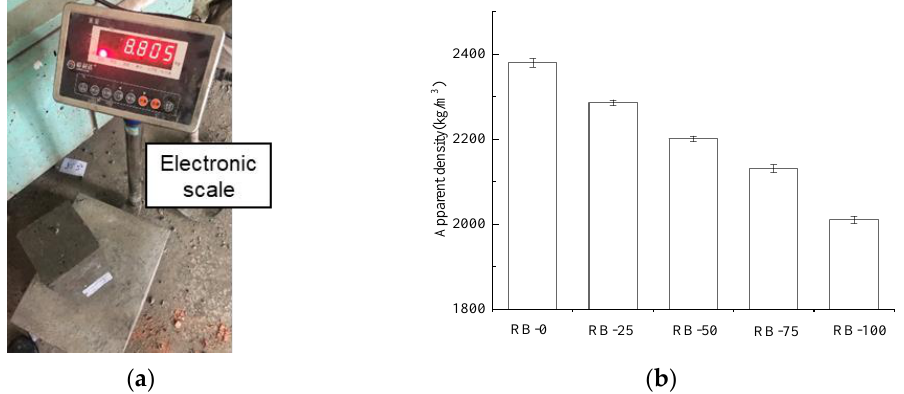
Figure 7. Apparent density of concrete experiment: ( a ) Apparent density test, ( b ) Apparent density of recycled concrete with different red brick contents.